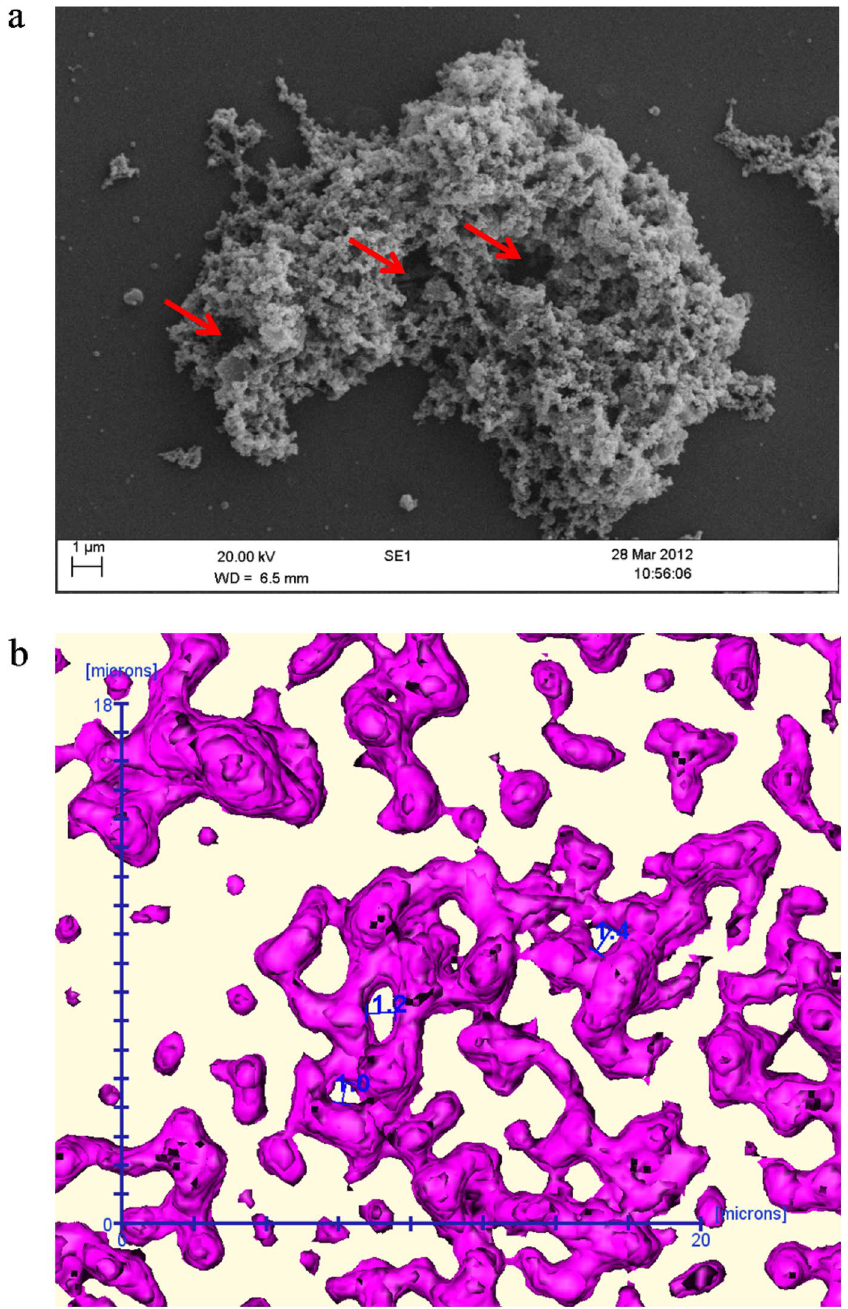
Figure 5. ( a ) Scanning electron microscopy image of Mycoplasma fermentans ATCC19989 determining channel diameter sizes compared to ( b ) that with confocal laser scanning microscopy (MATLAB ver R2013B, https:// uk. mathw orks. com/) (Amira ver 5.4 https:// www. therm ofish er. com/ uk/ en/ home/ indus trial/ elect ron- micro scopy/ elect ron- micro scopy- instr uments- workfl ow- solut ions/ 3d- visua lizat ion- analy sis- softw are. html, https:// www. vsg3d.